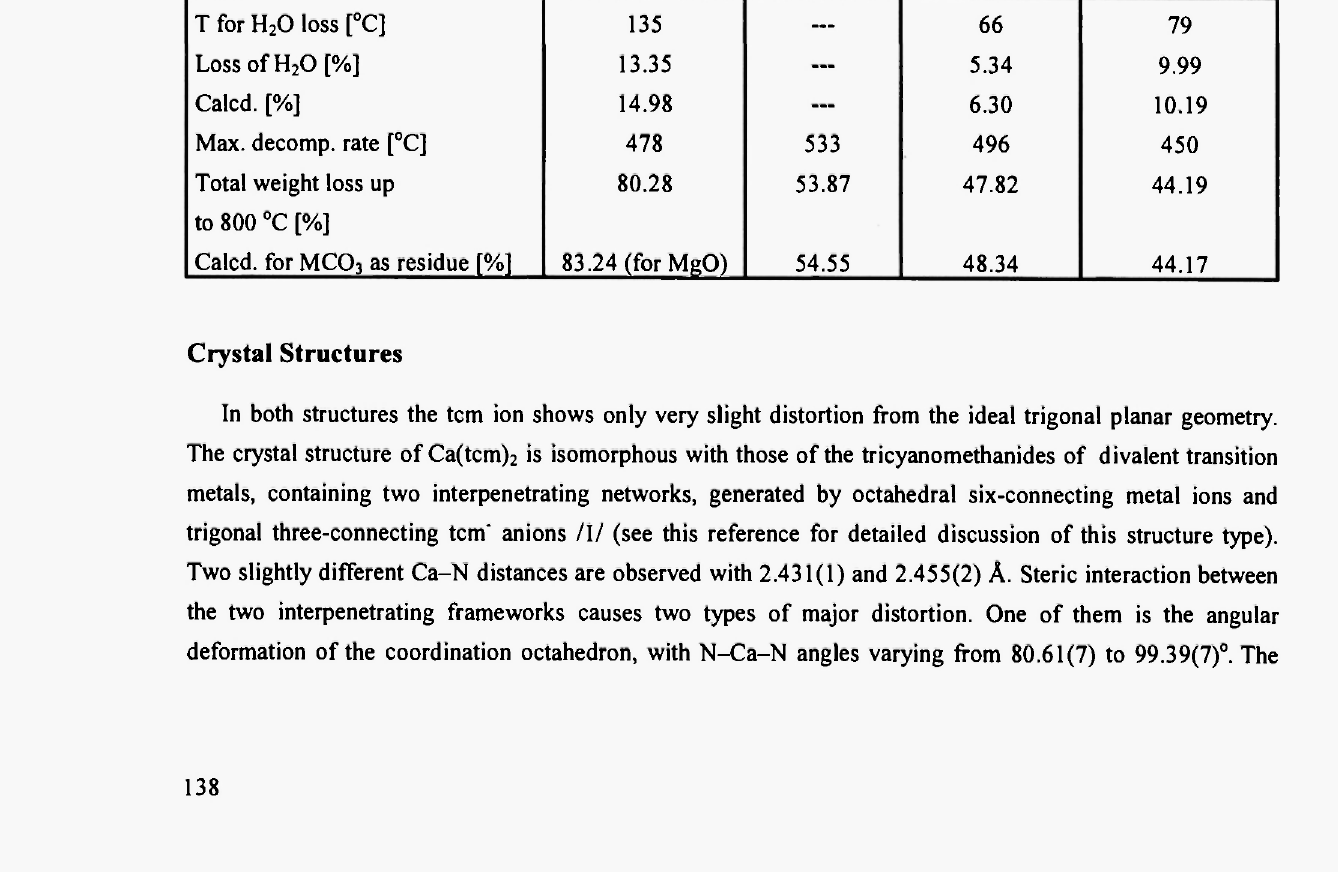
Thermogravimetric data for the alkaline earth